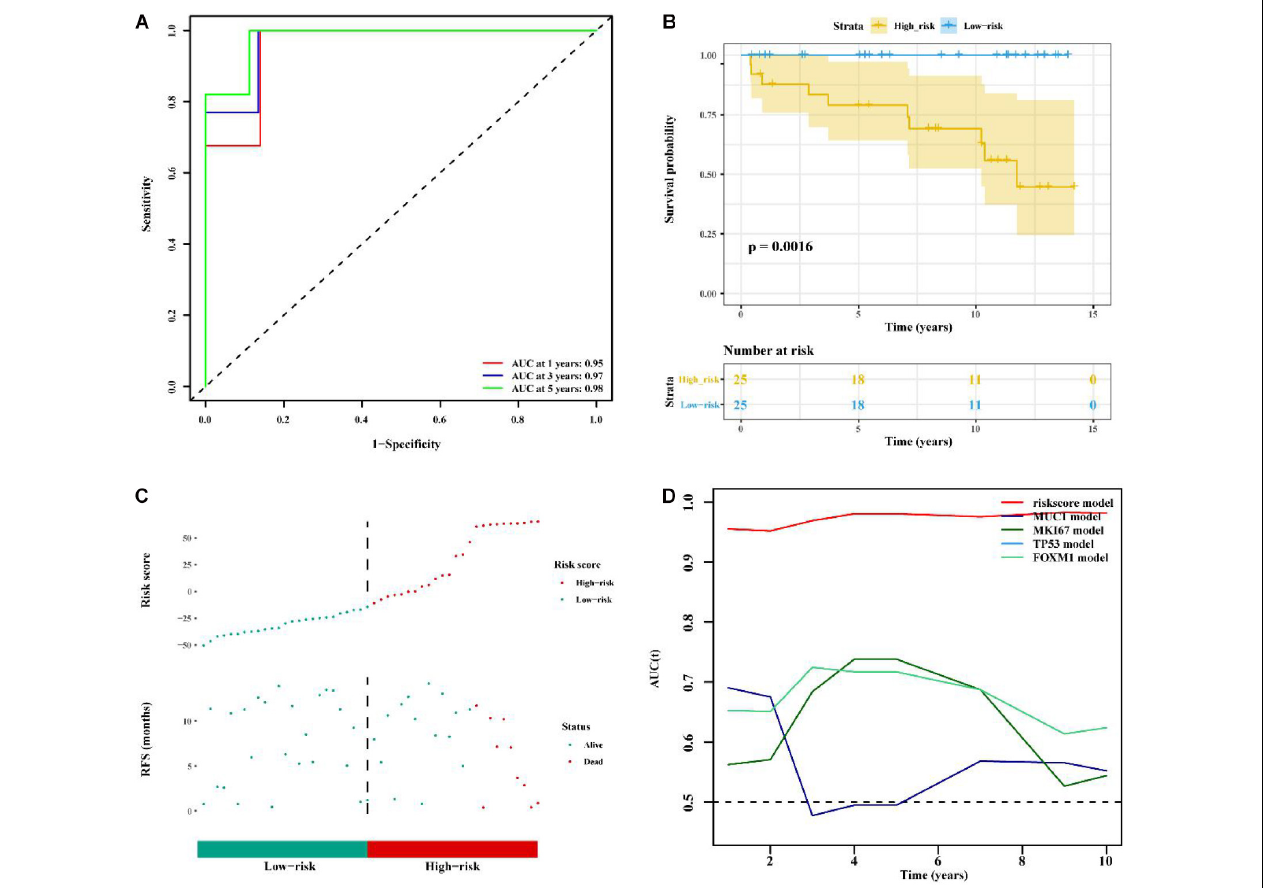
FIGURE 7 | Comparison of prognostic performances between the lncRNA signature and known prognostic biomarkers and validation using the BC-KR cohort. (A) The ROC curve to verify the prediction efficiency of the lncRNA signature. (B) Kaplan-Meier curve for the OS of BC patients in the high- and low-risk groups. (C) The risk-score distribution and duration of RFS of the lncRNA signature in the BC-KR validation cohort. (D) Time-dependent ROC curve to compare prediction efficiency between the lncRNA signatures and known prognostic biomarkers.